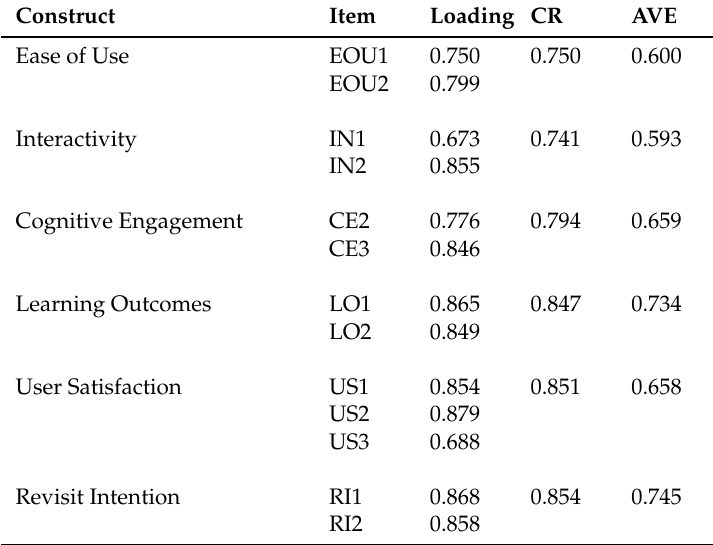
Table 4. Results of the measurement model.